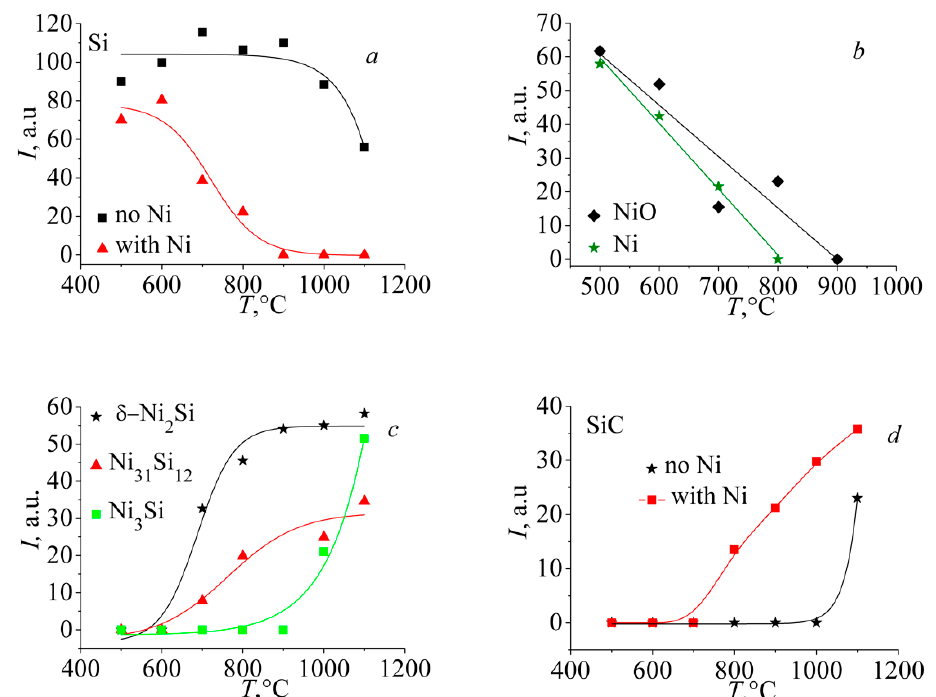
Figure 5. Change in the normalized value of the integral intensity of XRD peaks I / m for a single reflex of each phase, registered in samples with Ni: ( a ) Si 2 θ =28.4 ◦ ; ( b ) NiO 2 θ = 37.3 ◦ ; Ni 2 θ = 44.5 ◦ ;